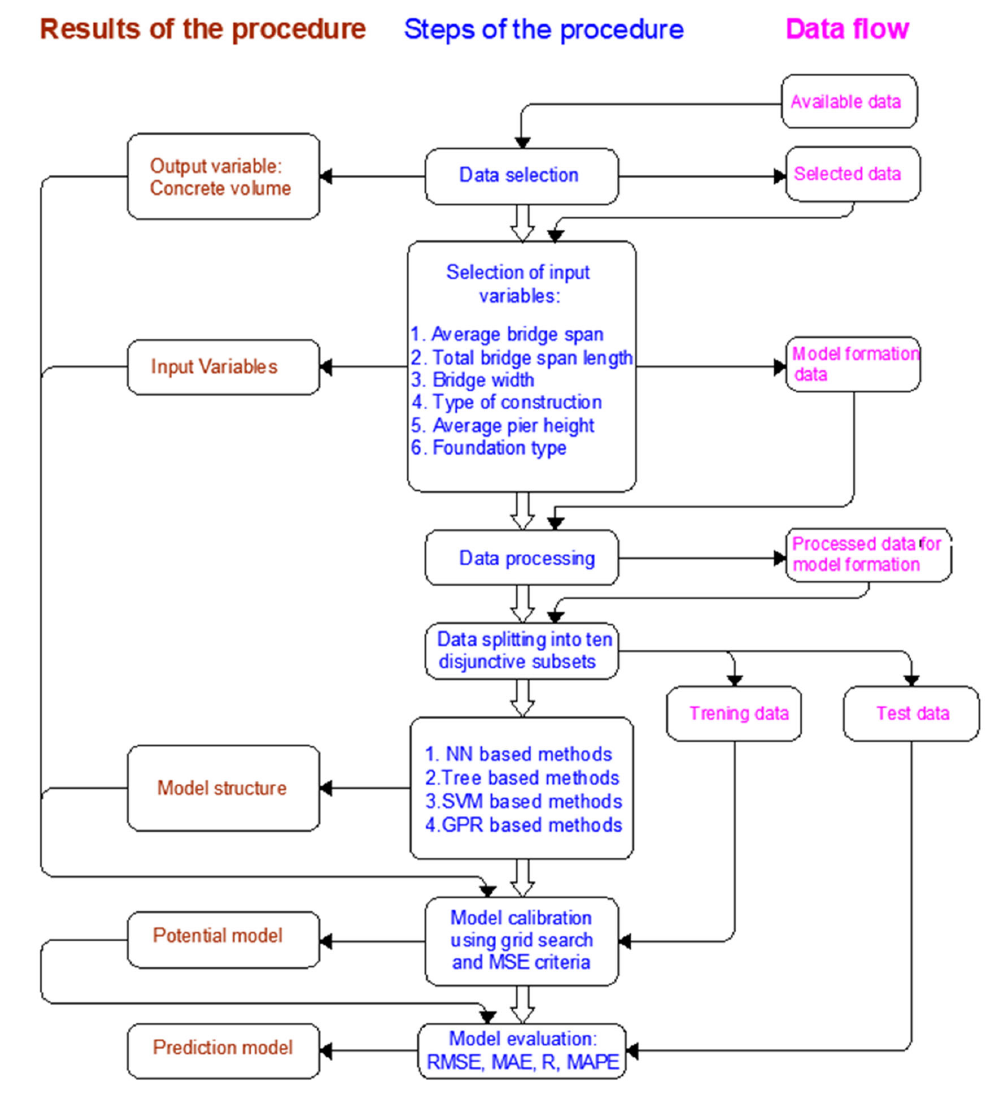
Figure 8. Systemic approach to model analysis.